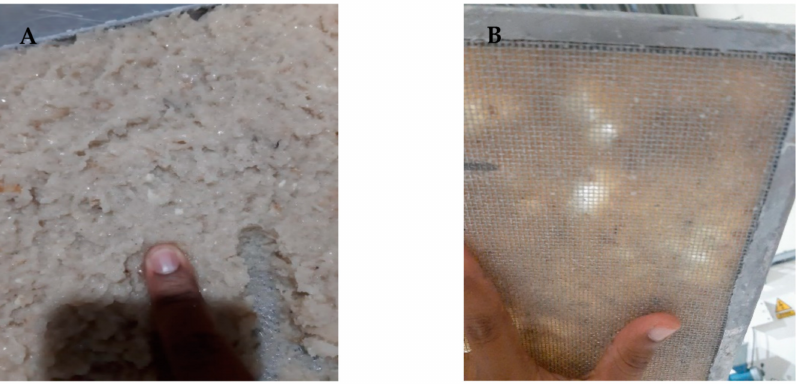
Figure 8. ( A ) Crust formation on the upper surface of the assessed samples; ( B ) Crust formation on the lower surface of the assessed